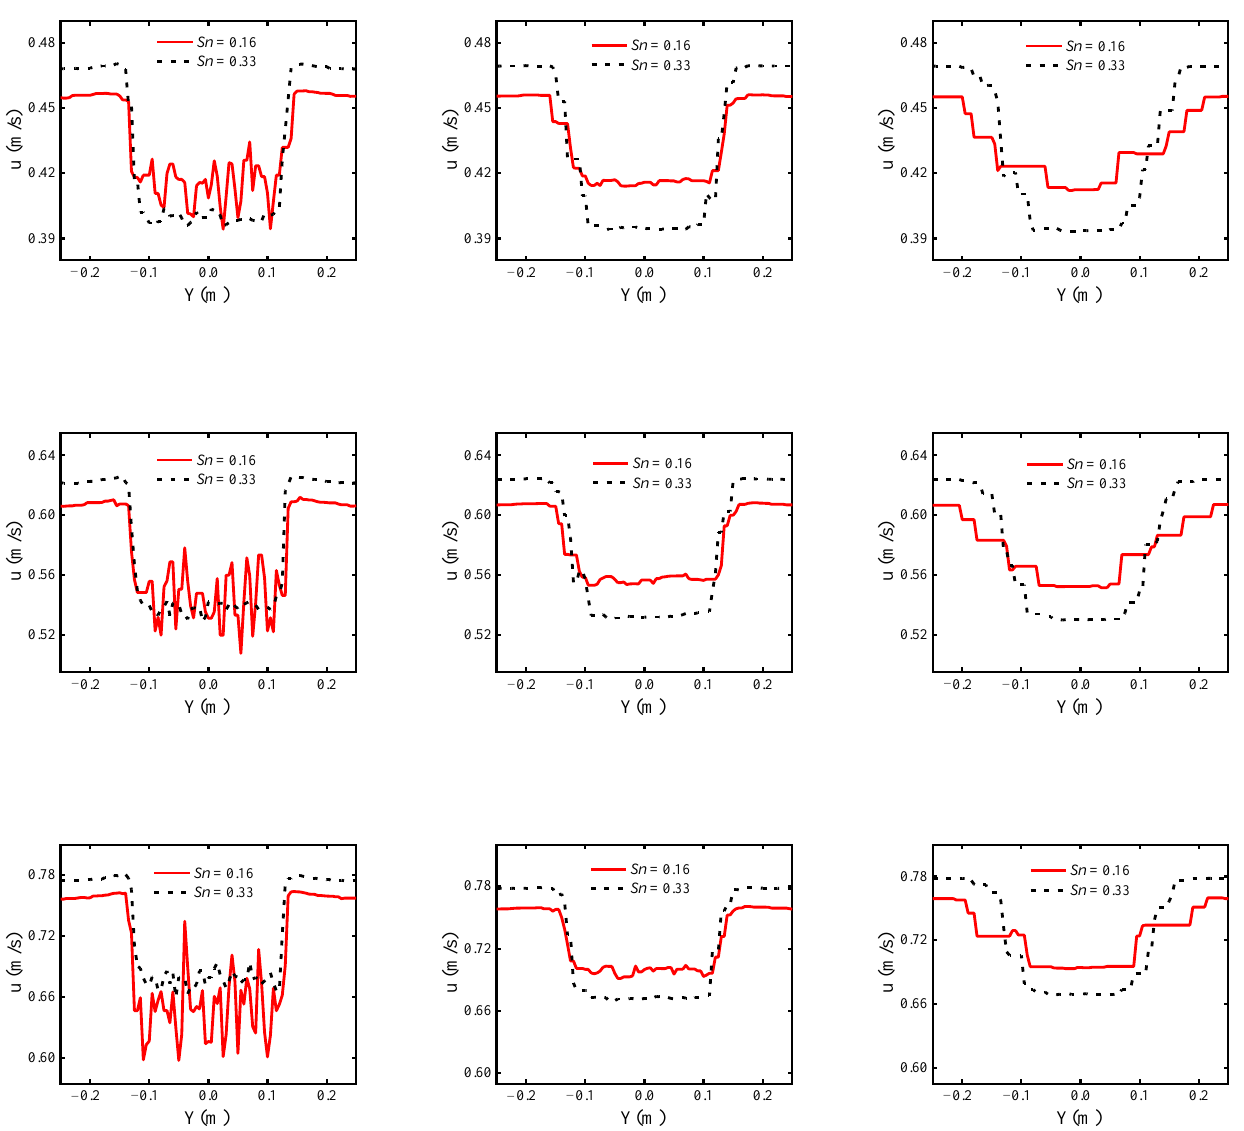
Figure 8. The magnitude of the flow velocity u along y -direction at different distances downstream of the net panel center. Here, the flow velocities from top to bottom are from 0.15 m/s to 0.75 m/s with an increment of 0.15 m/s.